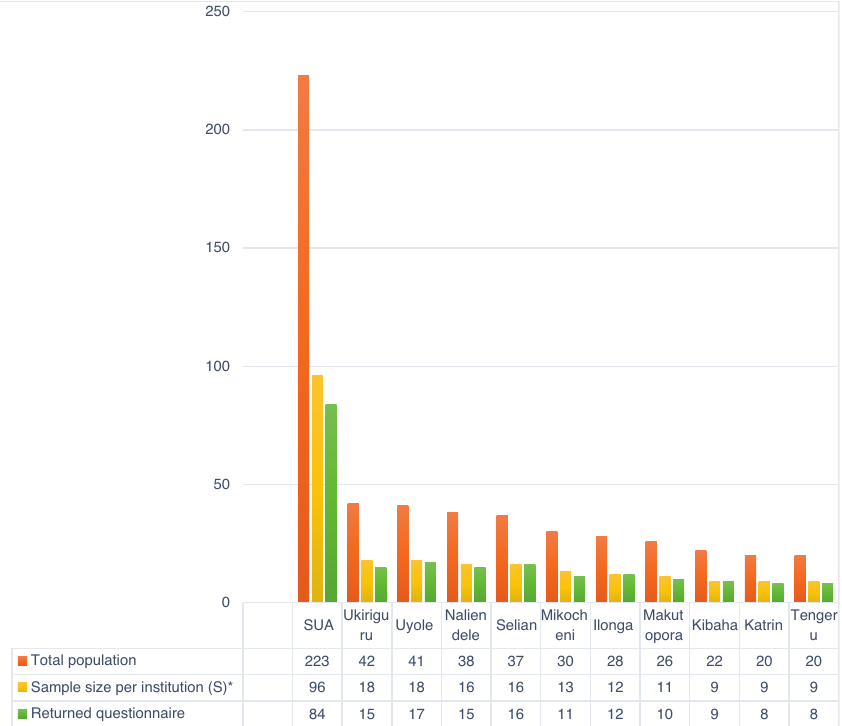
Fig. 3: Sampling distribution. Sample size per institution* = study sample size (n) (227) times population per institution over Total population